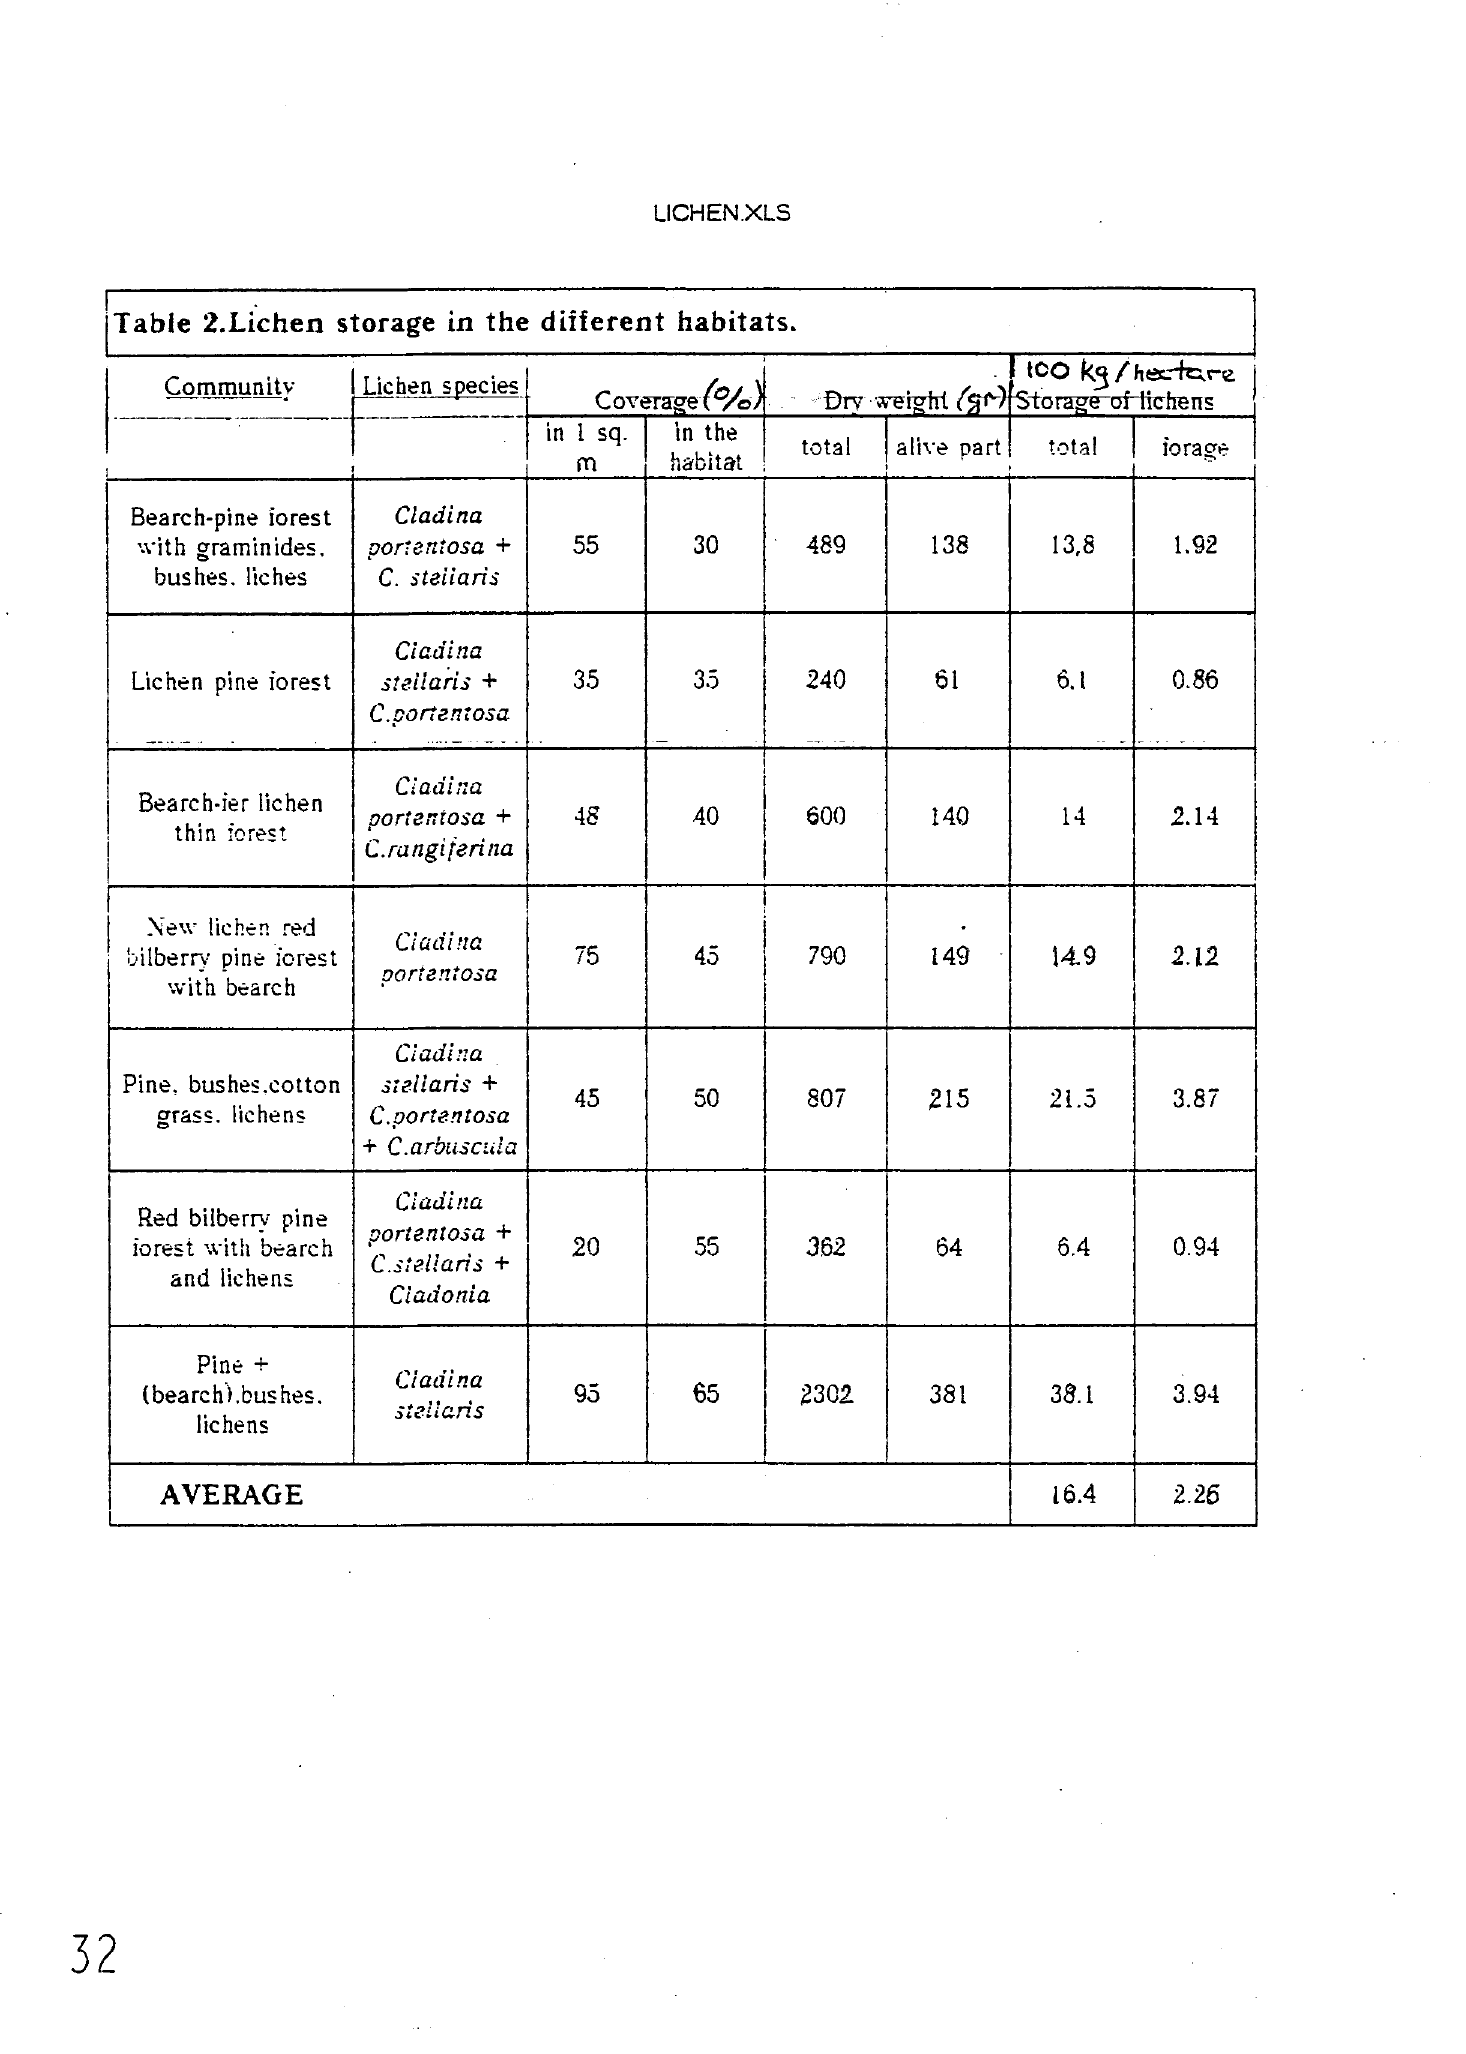
tCO kg/hecrfcr-e Coverage^©) Dry weight "Storagerof lichens in the in 1 sq. total alive part total habitat m